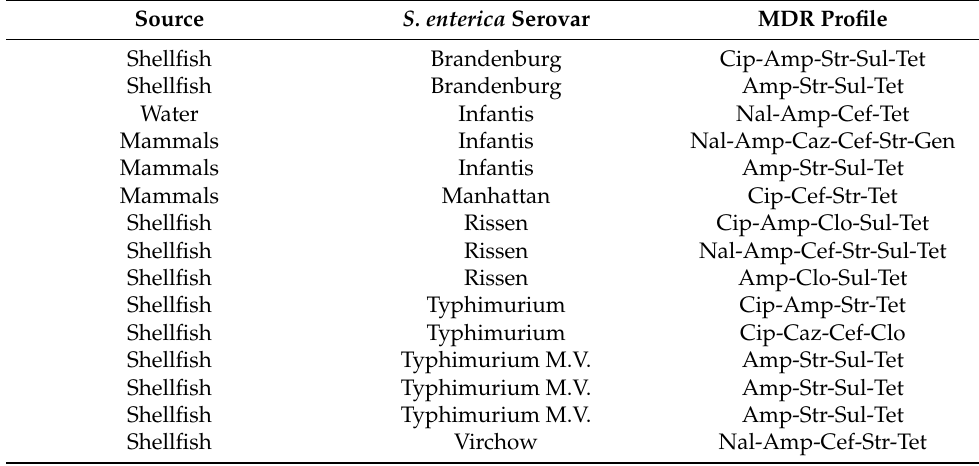
Table 5. Source of isolation of Salmonella serovars resistant to at least three antibiotic classes (multidrug-resistant;